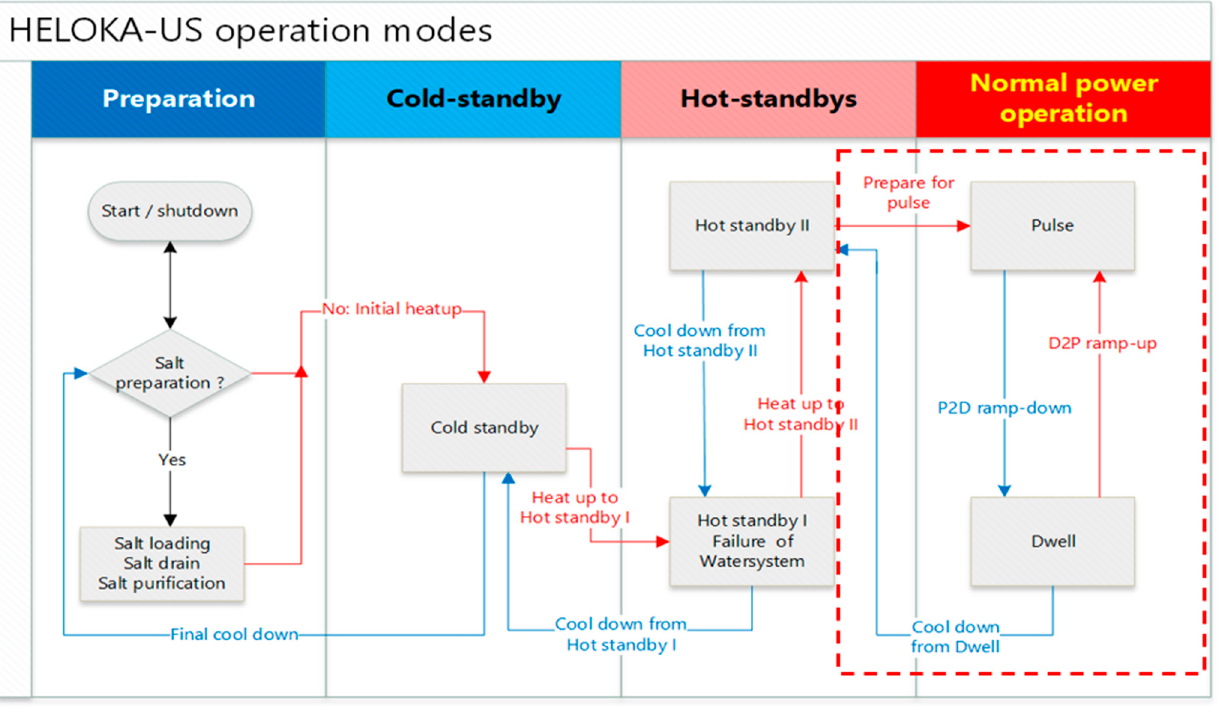
Figure 8. Operation modes in HELOKA-US. P2D: pulse-to-dwell transition, D2P: dwell-to-pulse transition.